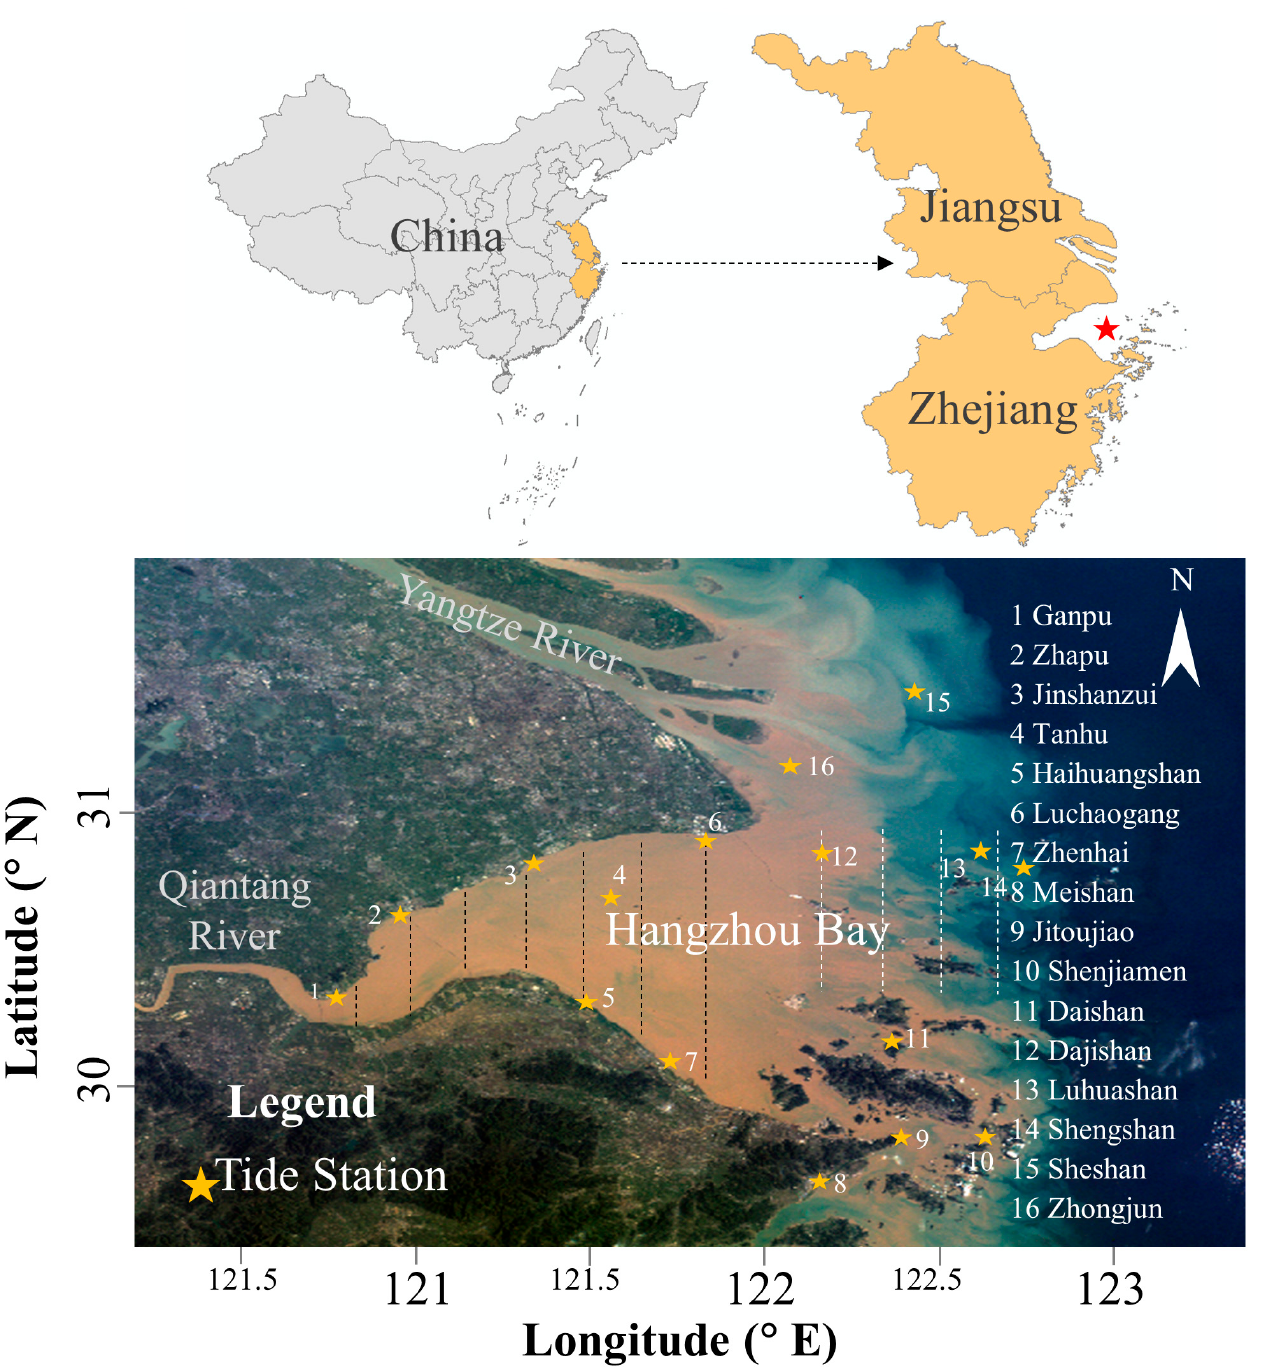
Figure 1. The HZB and its adjacent areas shown in the GF-4 L1 true color composite image collected at 7:30:42 on 28 August 2017. The tide station for tide level data is indicated with a yellow pentacle. The black and white dotted lines are chosen to represent transects inside and outside HZB, respectively; concentration was then calculated along transects.